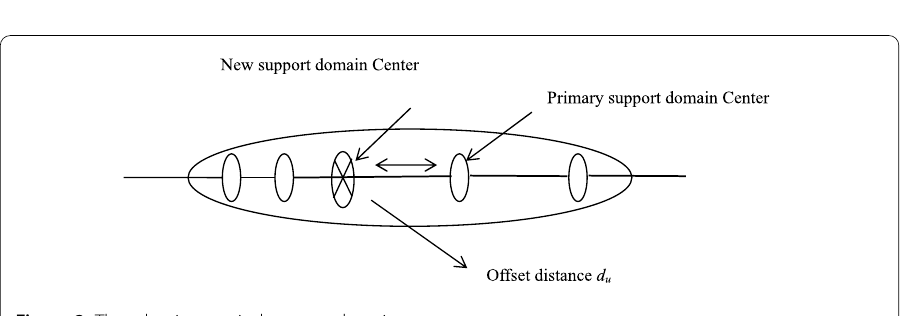
Figure 2 The adaptive upwind support